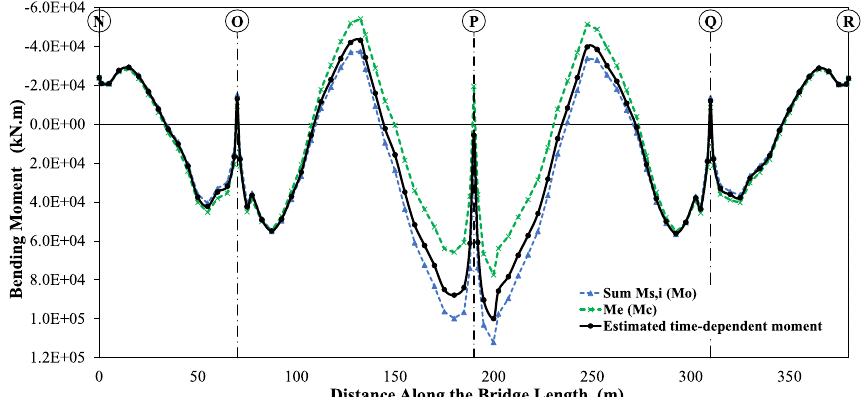
Fig. 7 Estimated time-dependent moments using the simplified approach per Kwak and Son (2002)–El Warrak Bridge